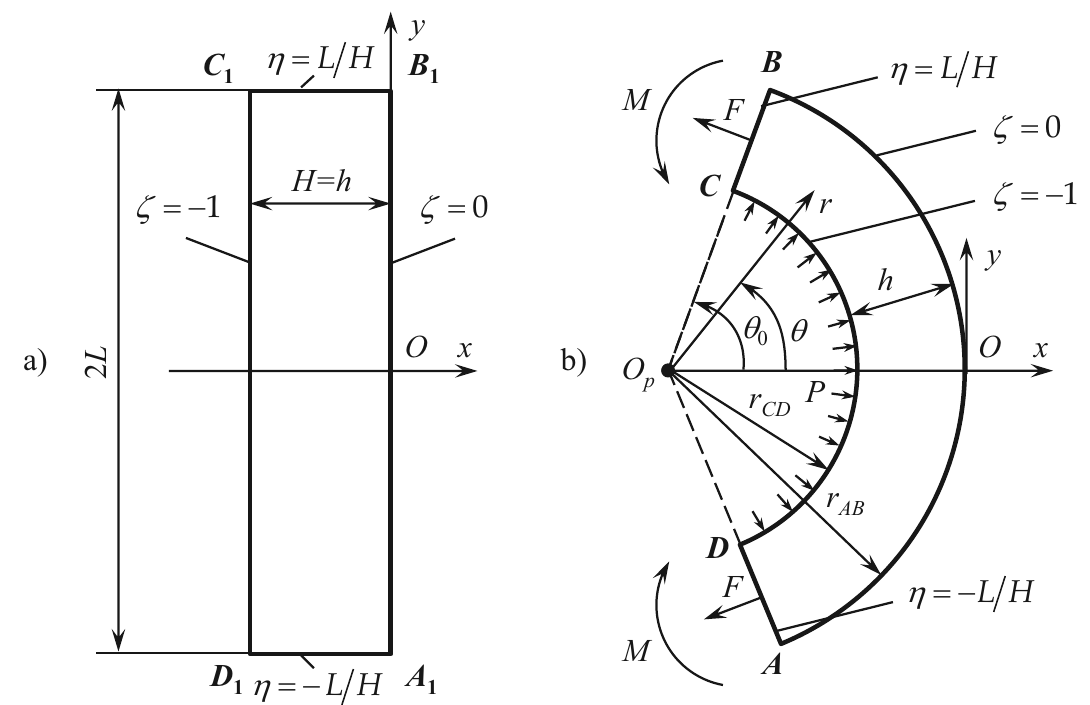
Figure 2. Schematic diagram of the bending process: ( a ) initial configuration; ( b ) intermediate and final